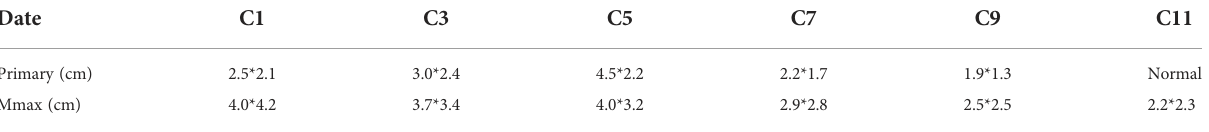
C1-C11: The number of cycles of treatment. Primary: The size of the primary lesion; Mmax; The size of the largest liver